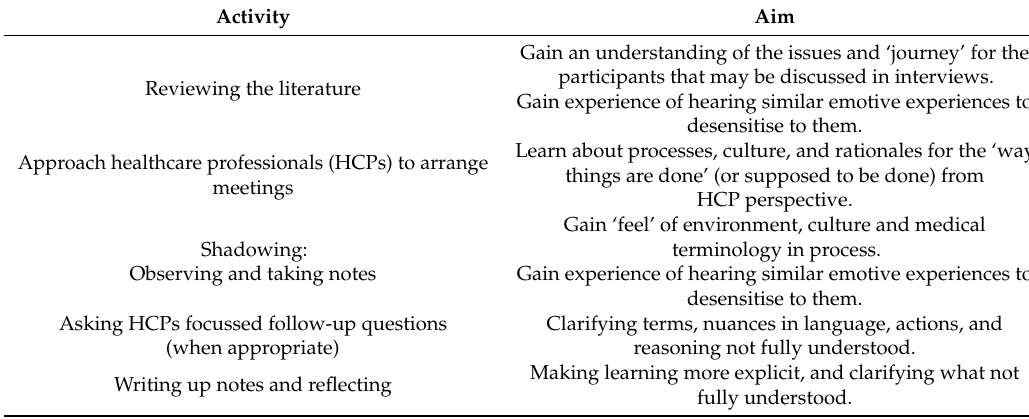
Table 1. Steps taken by the researcher to prepare for interviewing children and young people (CYP) with serious conditions (including